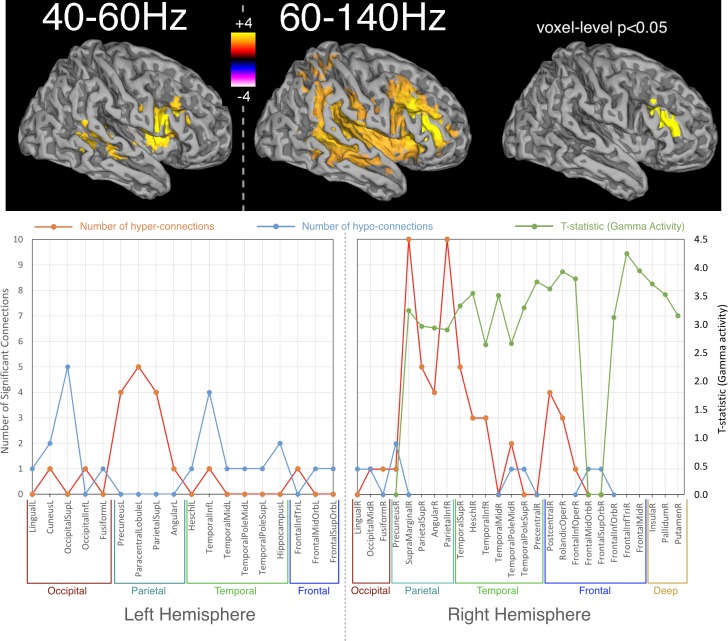
Spatial distribution of differences in oscillatory activity, between young APOE-ε4 carriers and their matched controls and the relationship with hyper- and hypo- connectivity.Top panel shows differences in activity as a coloured overlay depicting unpaired t-statistics (thresholded at p<0.05, corrected using TFCE), with yellow/orange representing greater activity in the APOE-ε4 carriers. Significant effects were only found in the right hemisphere and only for the two gamma ranges tested, 40–60 Hz and 60–140 Hz. The overlays are shown depicted on a template brain surface. The far-right column shows the results for the 60–140 Hz comparison using a more stringent voxel-wise correction for multiple-comparisons. The bottom panel shows the distribution of differences in both connectivity and activity, between APOE-ε4 carriers and non-carriers, within each AAL node that shows any significant effect. For clarity the left and right hemispheres are shown separately. Red lines show the number of significant connections to/from each node that are of higher strength in APOE-ε4 carriers, compared to non-carriers. Blue lines show the number of significant connections to/from each AAL node that are weaker in APOE-ε4 carriers. For the right hemisphere only, as effects were only found on the right, the green lines show the most significant t-statistic found in each AAL region for the analysis of gamma activity. Positive values indicate that gamma activity, in either band, was higher in APOE-ε4 carriers compared to non-carriers. Note that connection numbers are the sum across all frequency ranges tested, with most of these coming from the low frequencies – only one connection (FrontalInfTriL to TemporalPoleMidR) showed hyperconnectivity in the gamma range. In contrast, only gamma showed hyperactivity, so the green lines/marker exclusively reflect right-hemisphere gamma hyperactivity. The spreadsheet used to generate the graphs on this figure can be found at http://dx.doi.org/10.17605/OSF.IO/E4CJX.